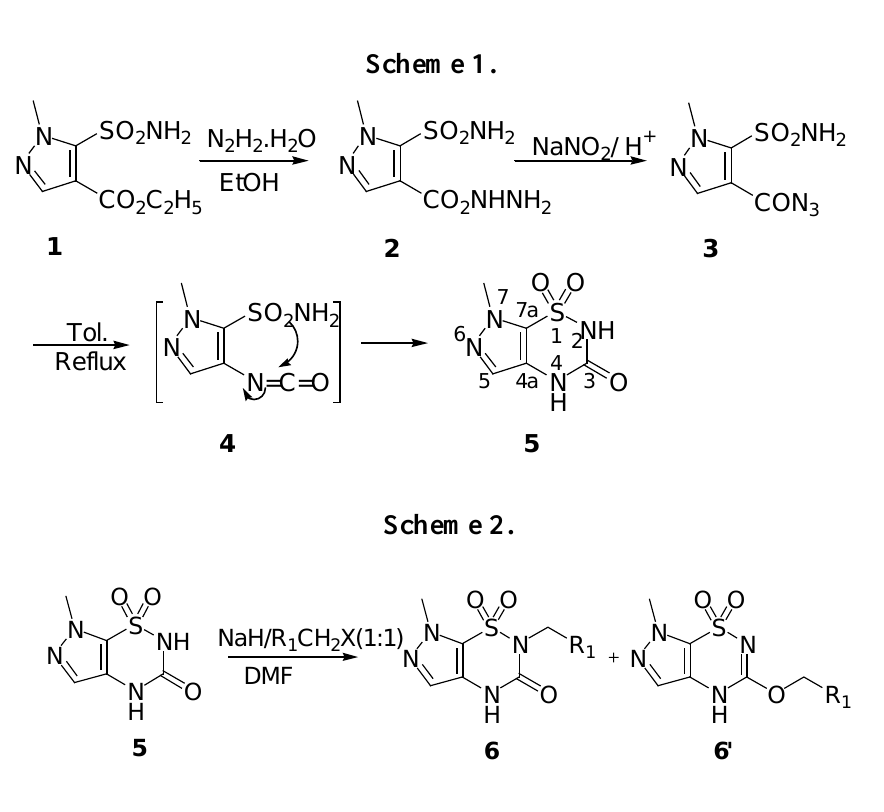
-substituted derivatives 6a-d and O -alkylated derivatives 6’a-d of Table 1. N 2